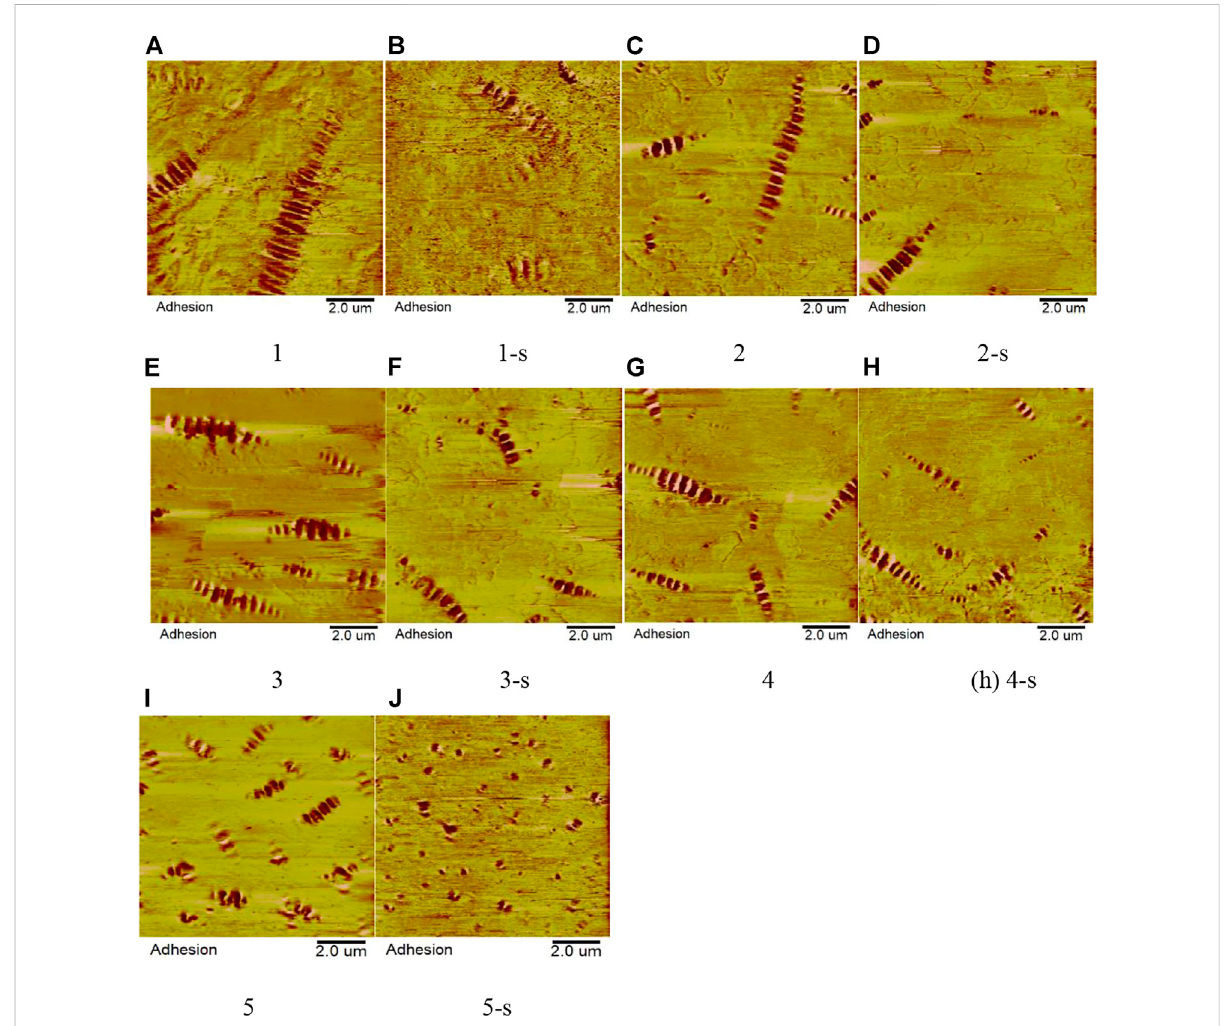
FIGURE 4 Two-dimensional adhesion diagrams for the samples presented in Table 3.